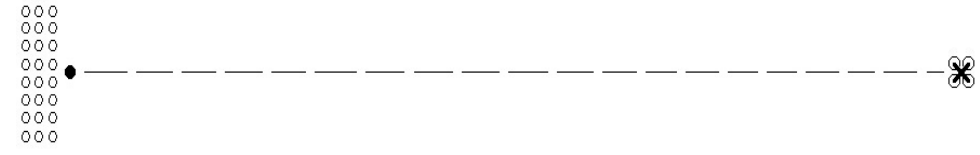
Figure 2. Locations of participants (o) and drone ( ), top view.